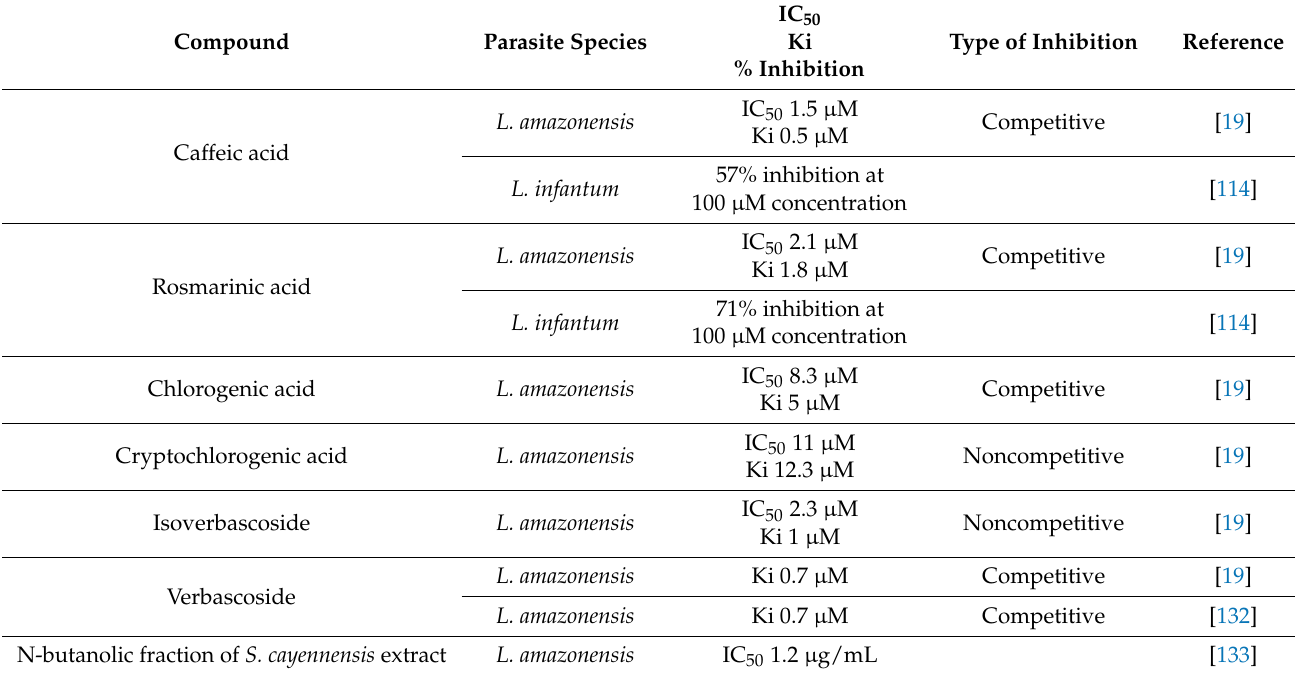
Table 8. Inhibition of recombinant L. amazonensis arginase by cinnamic acid